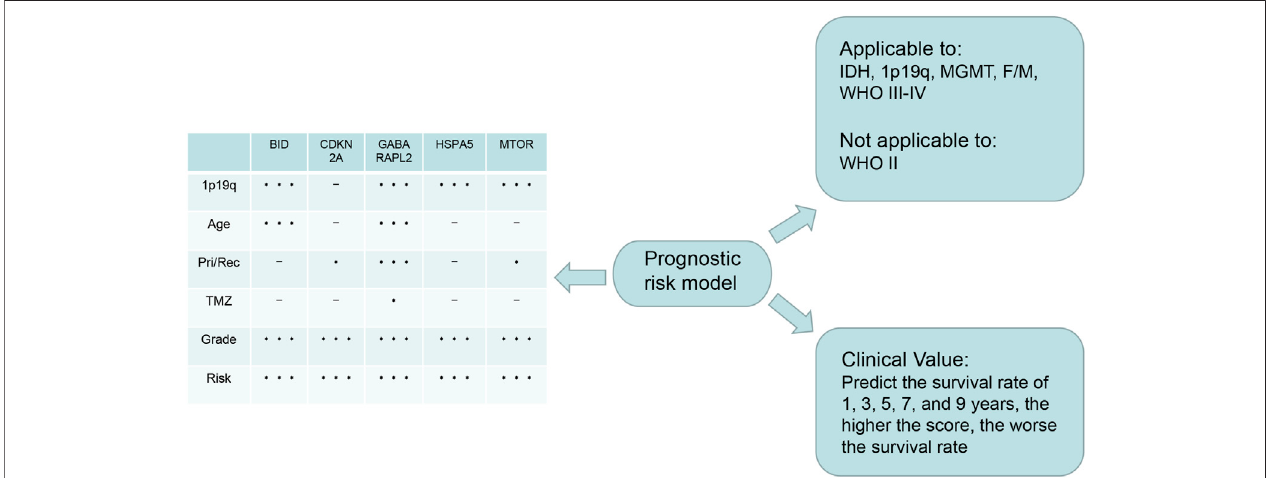
FIGURE9| Summary:Thelowerrightistheapplicationvalueofthemodel,whichcanpredictthe1,3,5,7,and9-yearssurvivalrate;Theupperrightisthescopeof application of the model, which can be applied to IDH1 mutation/wild type, MGMT methylation/unmethylation, 1p19q deletion/no deletion, female/male, WHO III-IV glioma,exceptWHOIIglioma;Ontheleftistheexpressionofthe fi vegenesthatconstructingthemodelindifferentclinicalcharacters.Theexpressdifferencecanprovide a direction for future basic study.